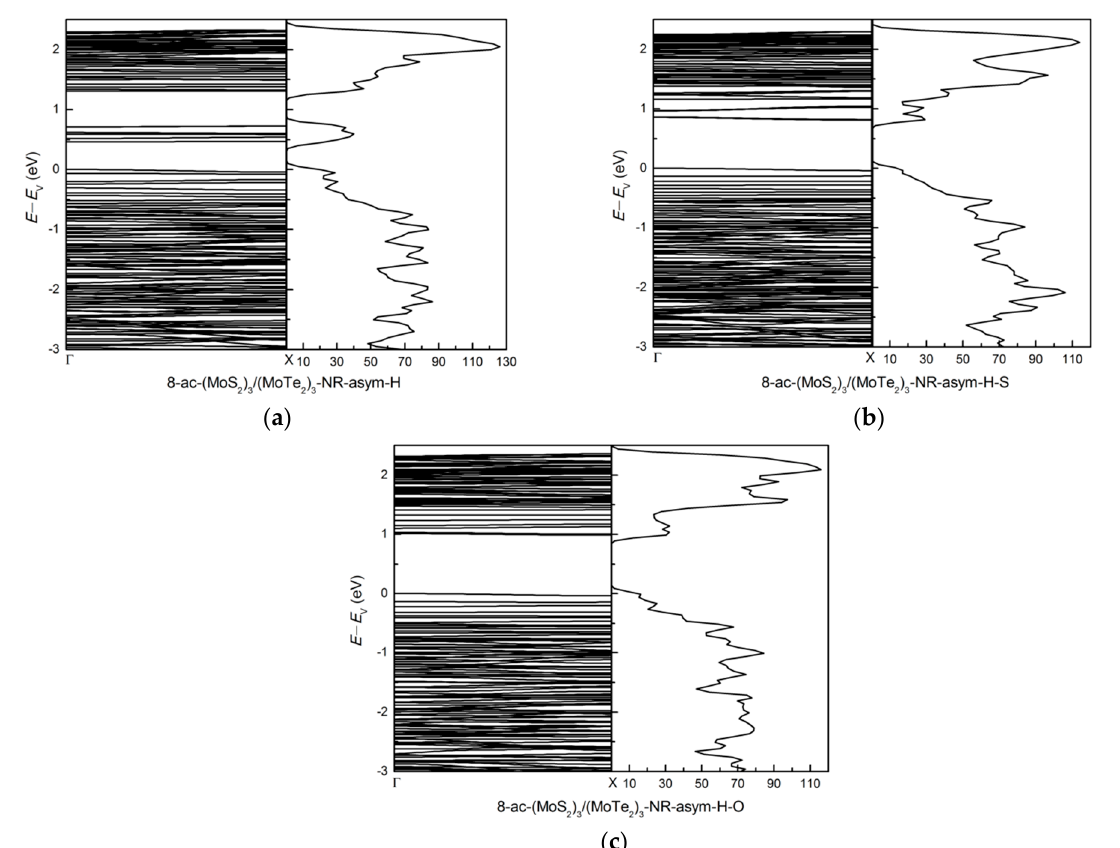
Figure 11. The band structure and dos: ( a ) 8-ac-(MoS 2 ) 3 /(MoTe 2 ) 3 -NR-asym-H, ( b ) 8-ac-(MoS 2 ) 3 /(MoTe 2 ) 3 -NR-asym-H-S and ( c ) 8-ac-(MoS 2 ) 3 /(MoTe 2 ) 3 -NR-asym-H-O.